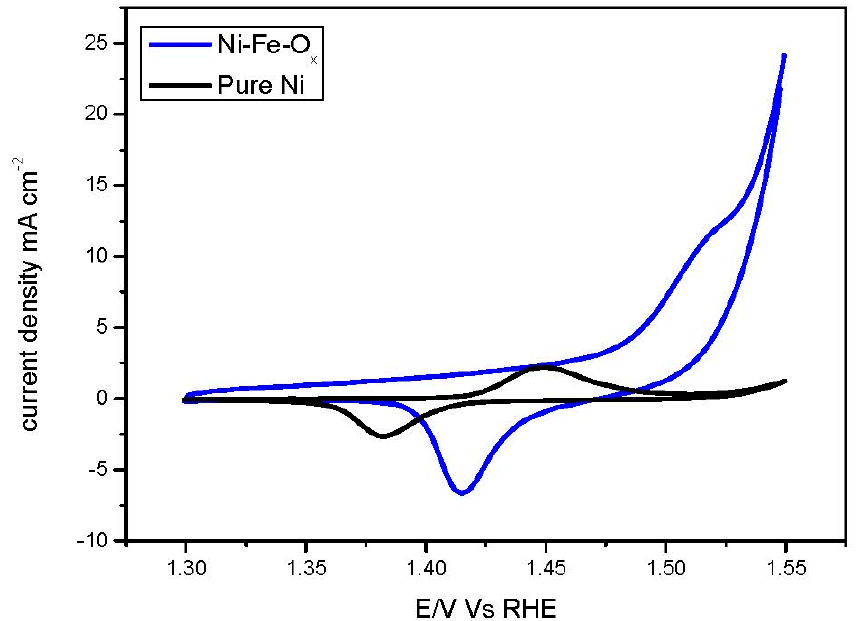
Figure 1. Cyclic voltammograms of Ni–Fe–O x during the potential cycle between 1.3 and 1.55 V vs. RHE in 1 M KOH.